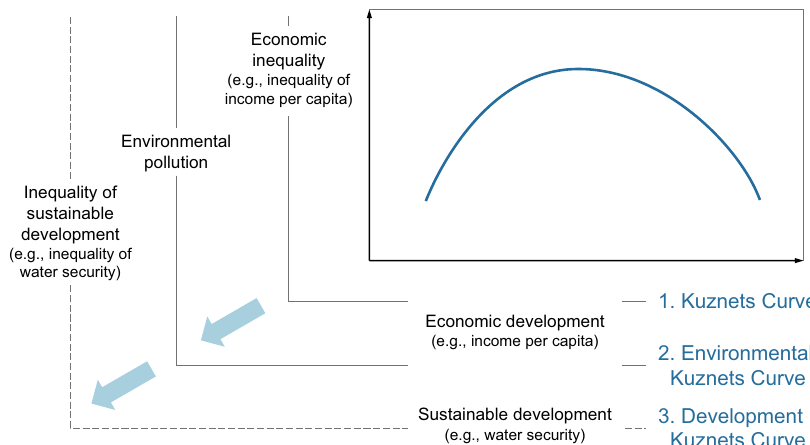
Fig. 1 Three stages of Kuznets Curve research. They are Kuznets Curve, Environmental Kuznets Curve, and Development Kuznets